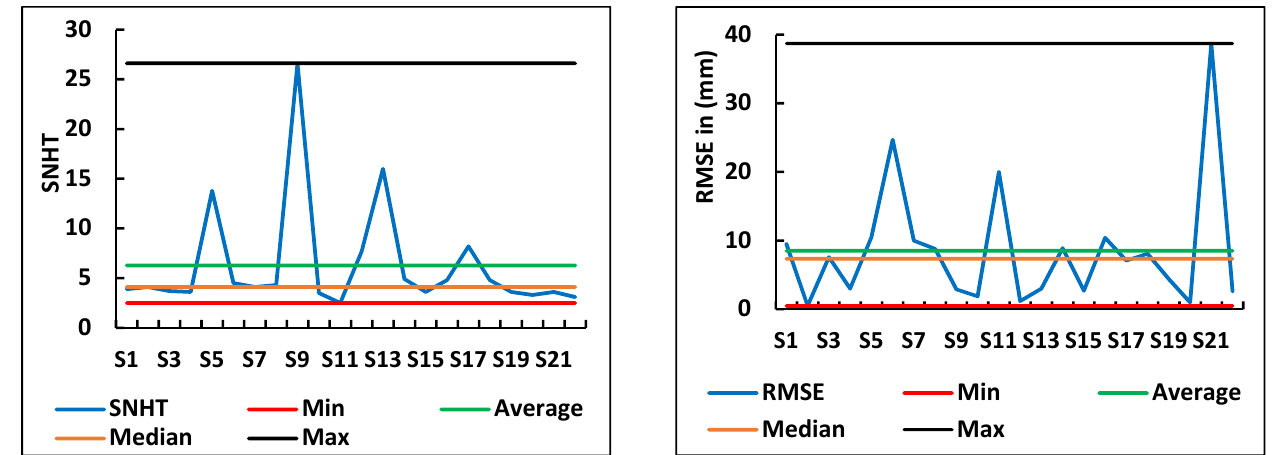
Figure 7. RMSE and SNHT values after homogenization.